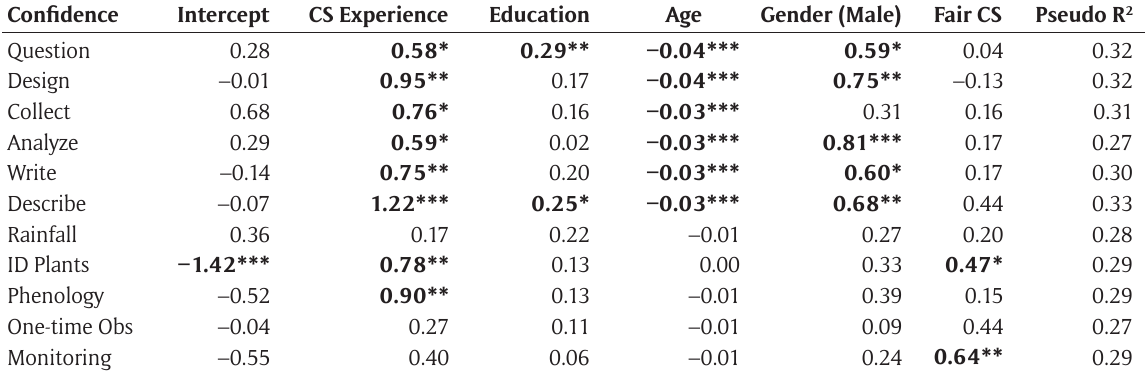
Figure 3: Percentage of participants who reported that they would feel confident (a) or enjoy (c) science process tasks; percentage of participants who reported that they would feel confident (b) or enjoy (d) engaging in nature-based data collection tasks. Details on tasks can be found in the text. Different letters between tasks indicate significant dif- ferences (p < 0.05) based on pairwise chi-square tests with Bonferroni corrections. N Table 2: Regression coefficients with confidence in citizen science activities as dependent variables, and prior citizen science experience, education, age, gender, and participation in other fair activities as independent variables. Bolded coefficients indicate significant p-values: *p < 0.05, **p < 0.01, ***p < .001. N = 357. Confidence Intercept CS